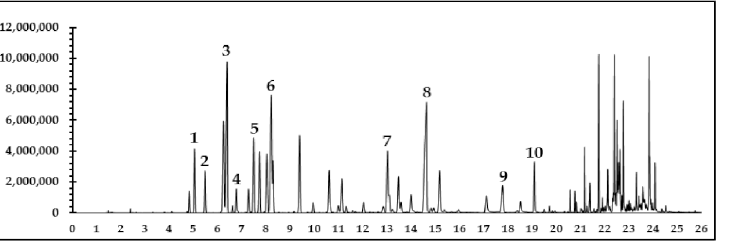
Figure 6. GC-MS total ion chromatogram of the mixed oil distilled from the herbal compress mixed ingredients. The peaks of the main constituents were identified by comparing the molecular mass from mass spectra data of each compound with the NIST library (Version 2.2) as (1) α -pinene, (2) camphene, (3) β -pinene, (4) β -myrcene, (5) 3-carene (6) D-limonene, (7) camphor, (8) terpinene-4-ol, (9) β -citral and (10) α